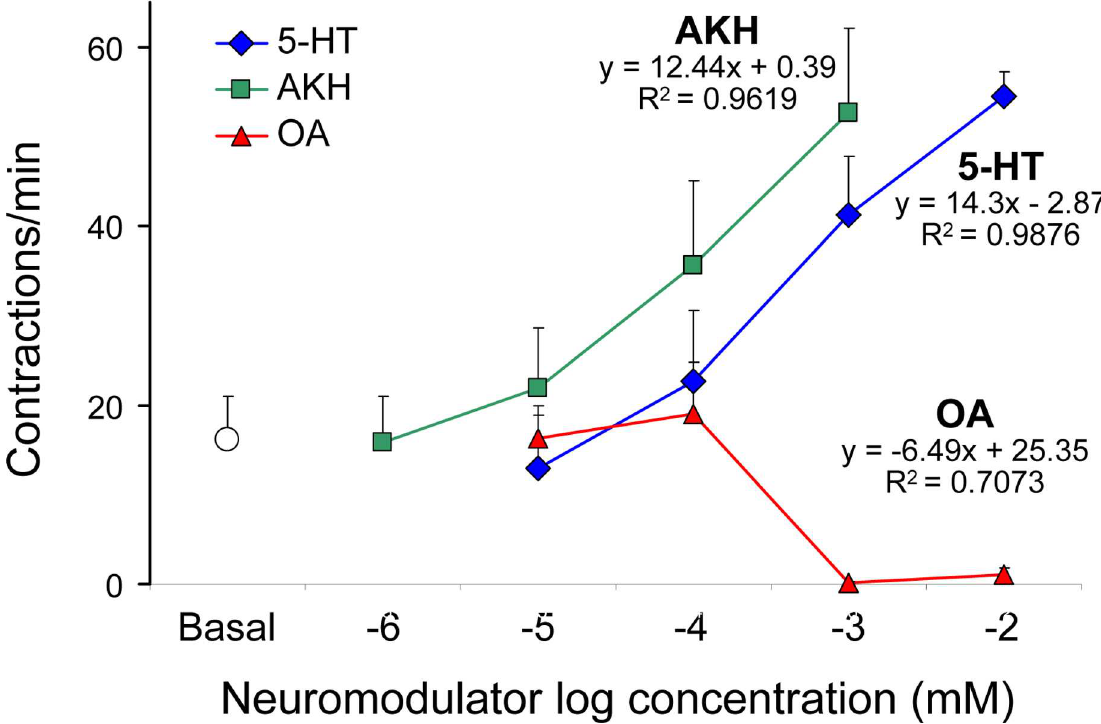
Fig 5. Dose-response curves for various neuromodulators on P5 crop contraction rate. Frequencyof contractions visually recordedfrom P5 of Drosophila Canton-Sstrain, determined over a 1-min interval, followingreplacementof hemolymphwith 0.01–10mM 5-HT and octopamine(OA) and 0.001–1mM AKH, as compared to the activity in Drosophila saline (basal). Mean values ± SE (vertical bars) from 10 replicates for each